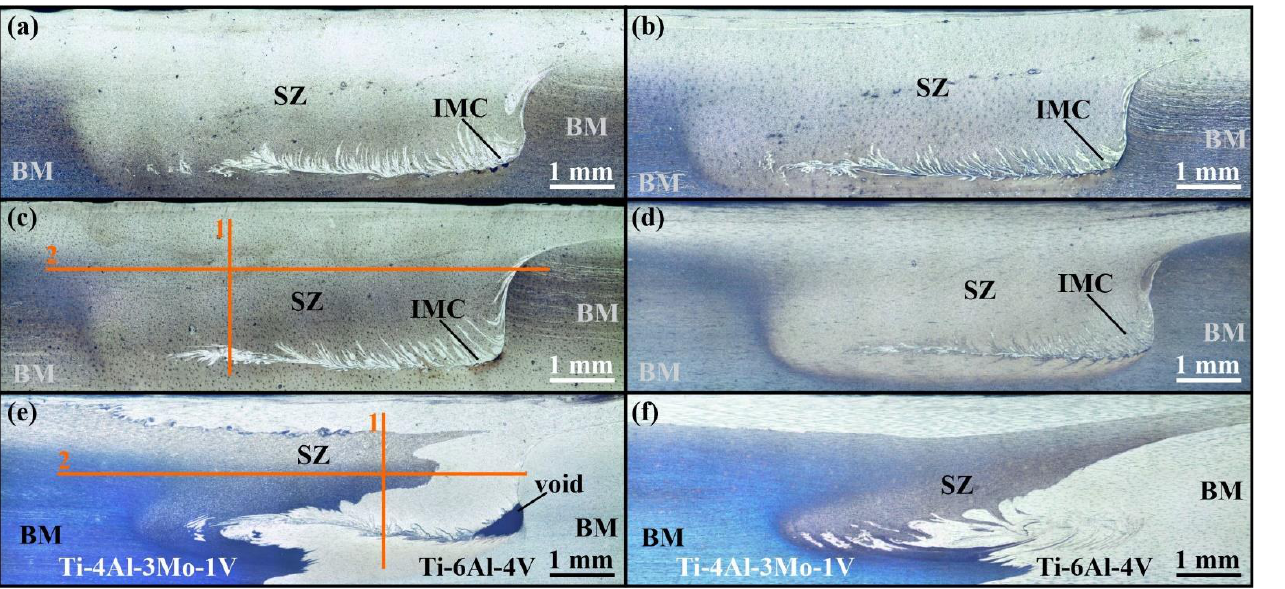
Figure 4. Microstructure of Ti-4Al-3Mo- 1V alloy joint specimen №1 ( a ), №2 ( b ), №3 ( c ), №4 ( d ), and Ti-4Al-3Mo-1V — Ti-6Al- 4V alloy joint specimen №5 ( e ), №6 ( f ).